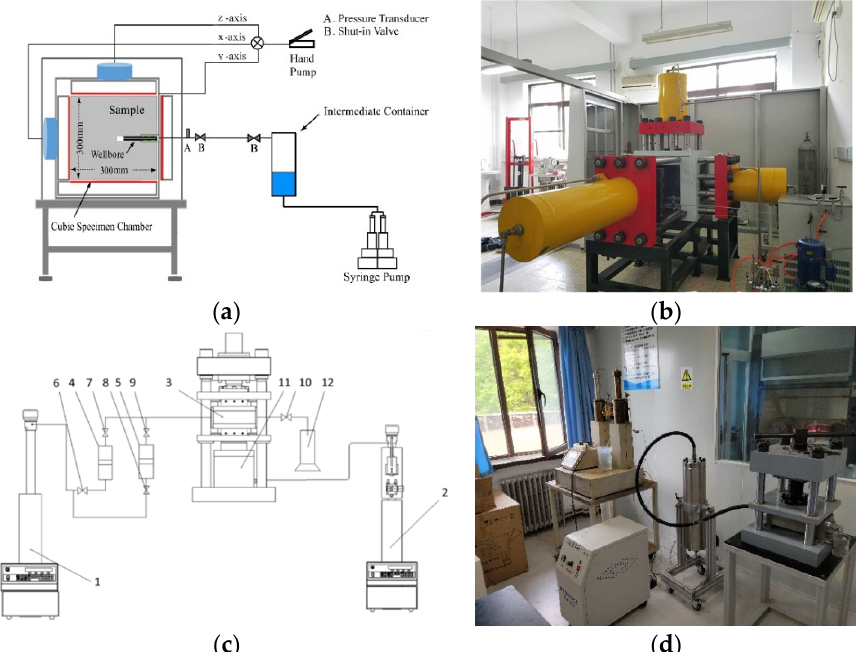
Figure 1. Experimental equipment ( a ) schematic diagram of triaxial fracturing equipment; ( b ) physical diagram of triaxial fracturing equipment; ( c ) schematic diagram of triaxial fracturing equipment (1: Syringe pump; 2: Confining pressure pump; 3: holder; 4&5: Intermediate container; 6–10: valve; 11: engine; 12: Measuring cylinder); ( d ) physical diagram of triaxial fracturing